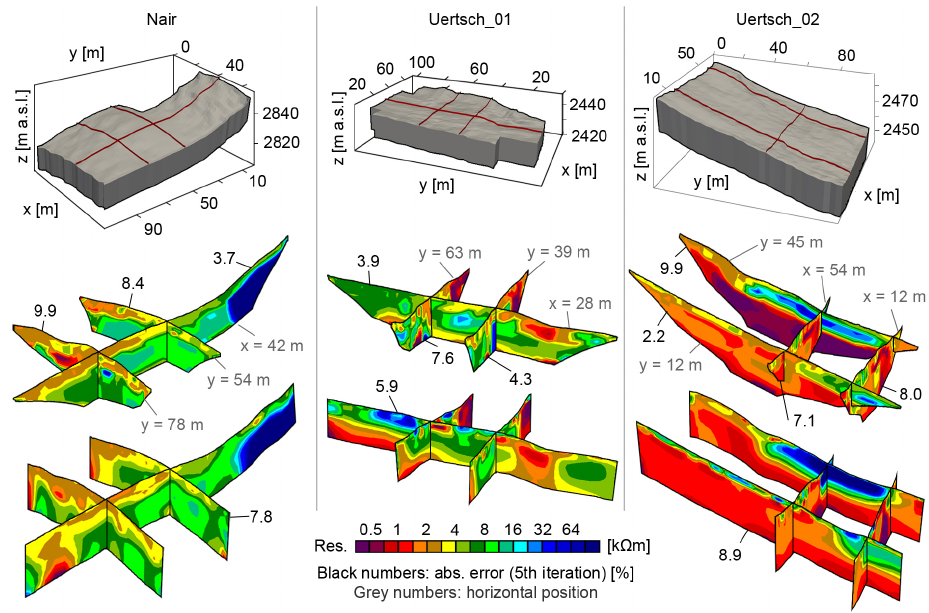
Figure 8. Comparison between independently inverted 2-D (central row) and 3-D (lower row) models. Upper row shows model representa- tions as blocks and positions of the selected